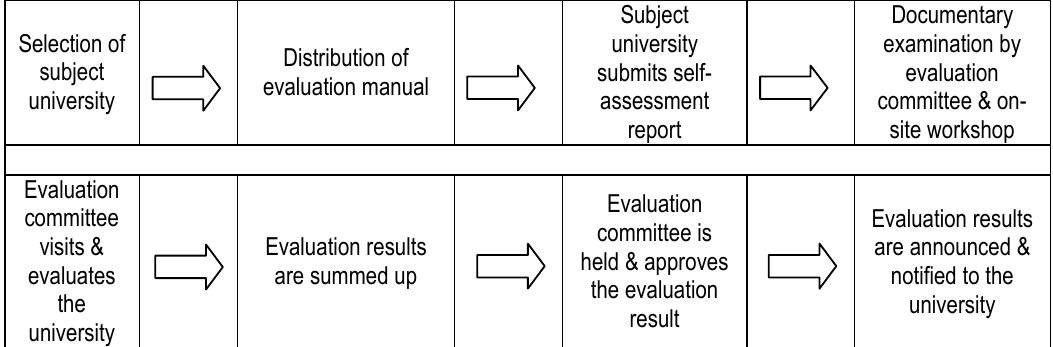
Figure 1. Evaluation progress Selection